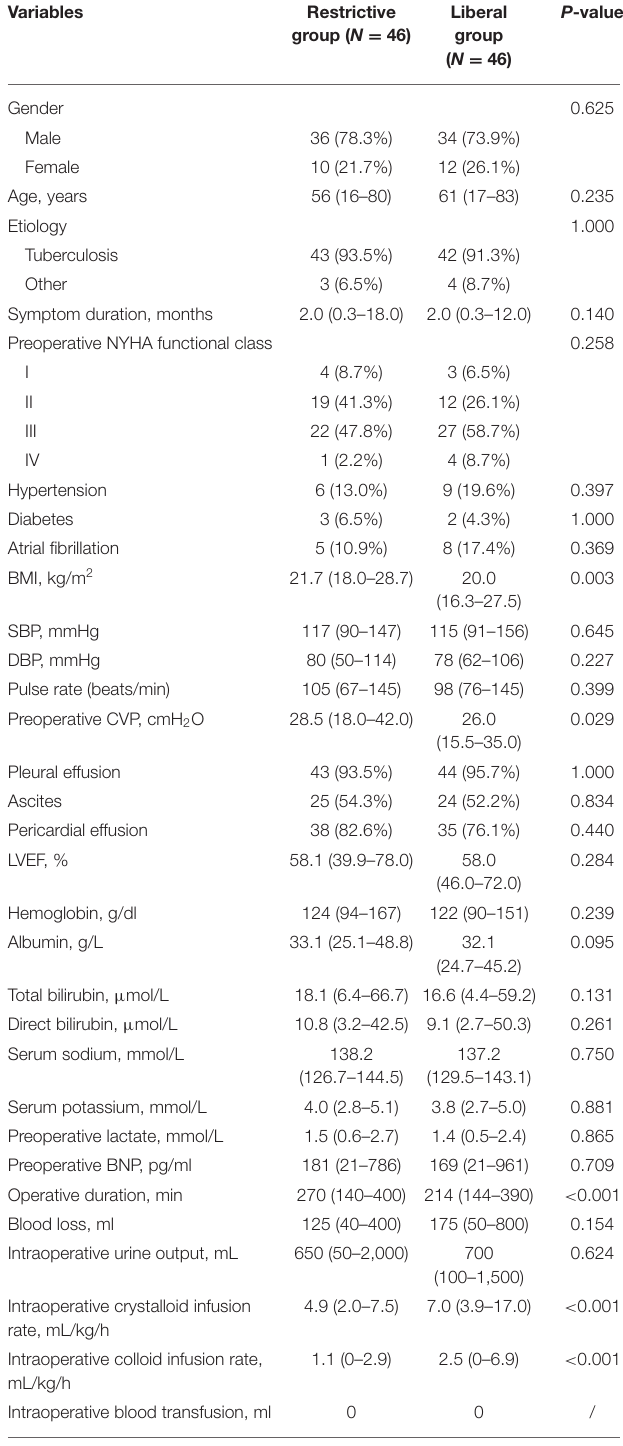
TABLE 1 | Clinical characteristics of the patients based on the intraoperative total fluid infusion rate.